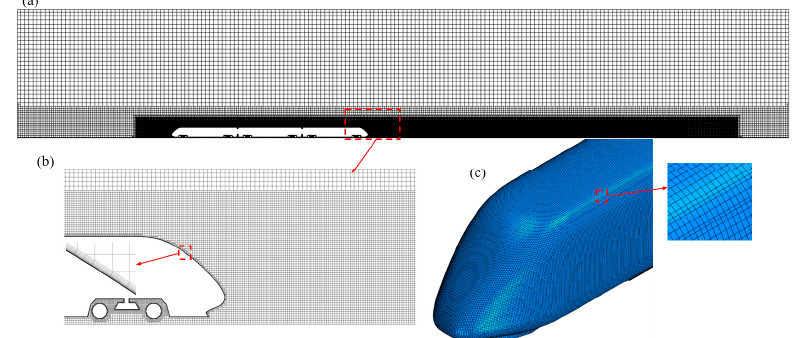
Figure 4. Medium grid: ( a ) plane at y = 0, ( b ) prism layer, and ( c ) train